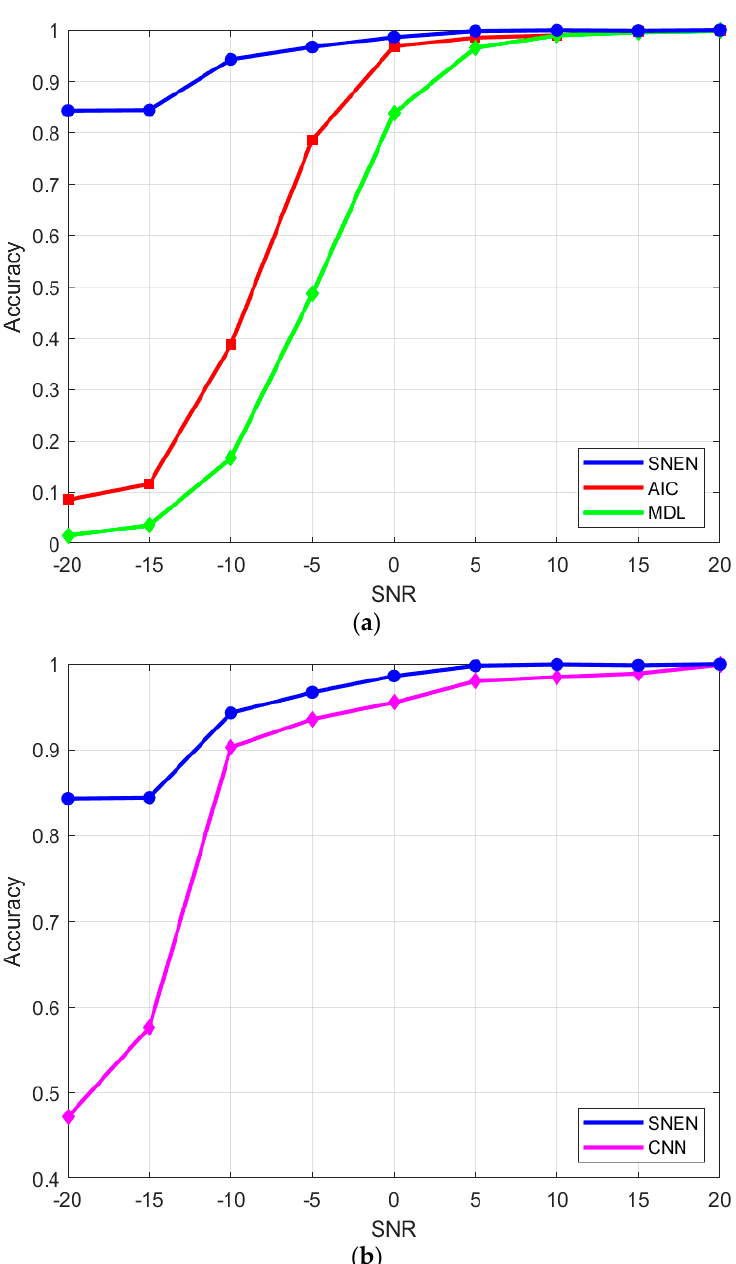
Figure 7. Comparison chart of various source number estimation methods. ( a ) shows the accuracy of this method compared to traditional estimation methods. ( b ) shows the accuracy of the present method compared with other CNN.